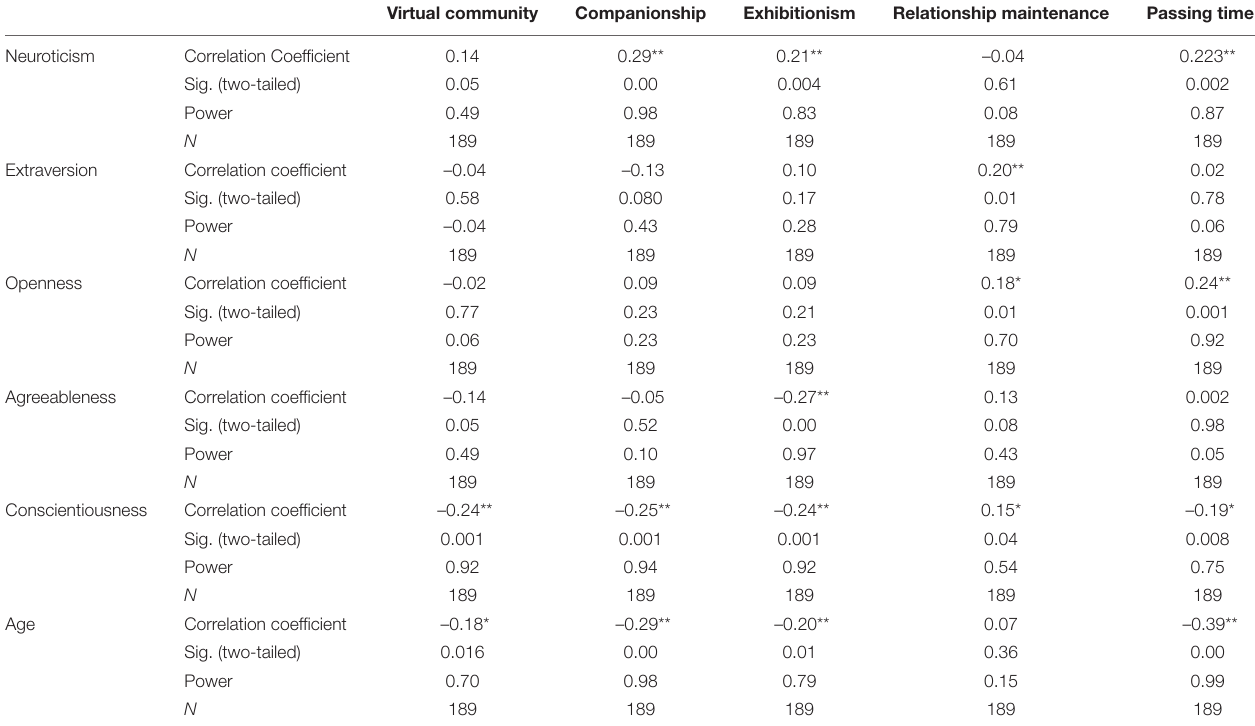
TABLE 2 | Correlating motives with age and Big Five trait